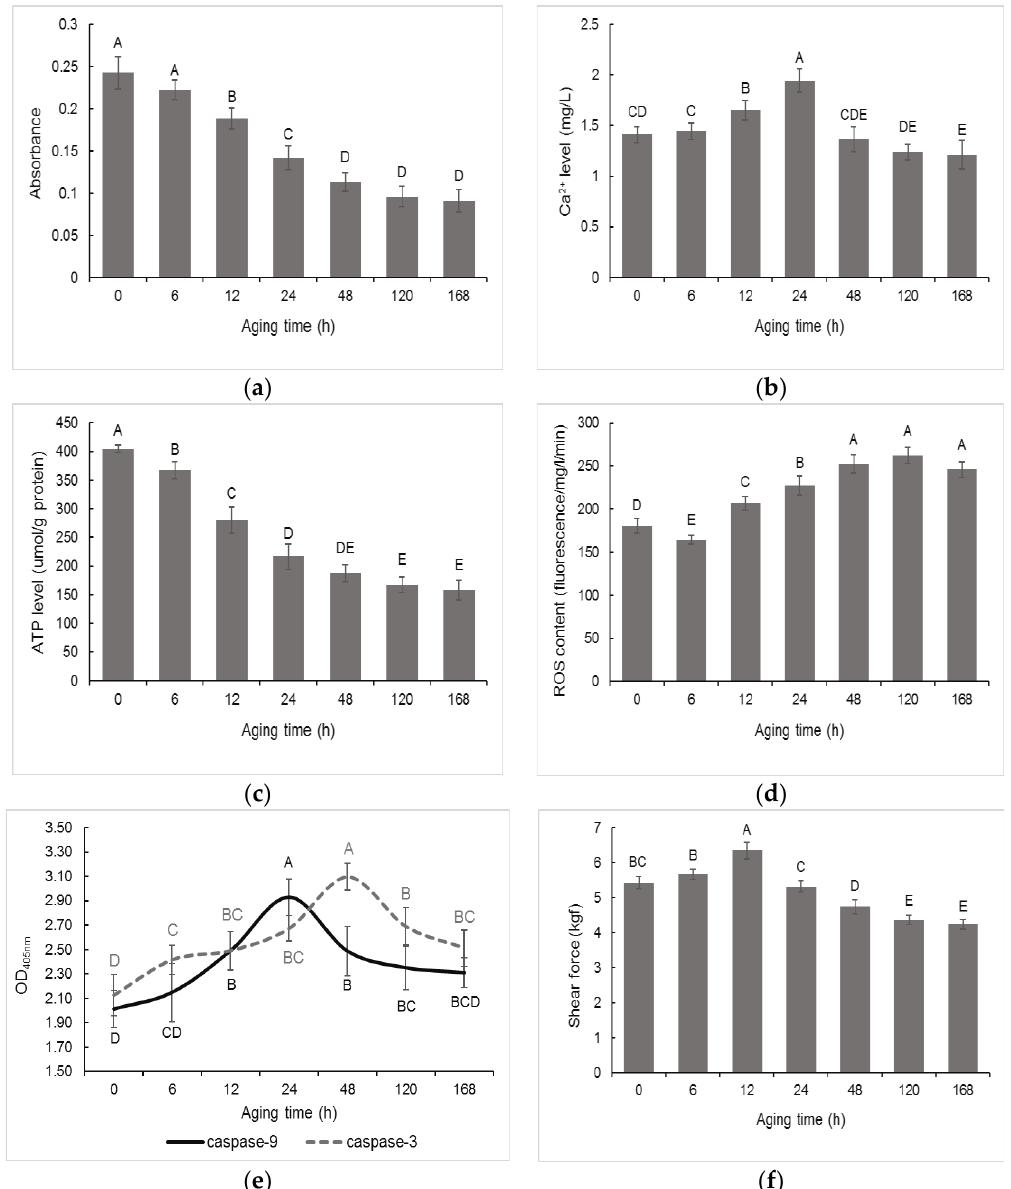
Figure 1. Changes in apoptosis related factors and tenderness in postmortem pork muscle. ( a ) mito- chondrial membrane permeability (MMP), ( b ) Ca 2+ level, ( c ) ATP level, ( d ) reactive oxygen species (ROS) content, ( e ) caspase-9/-3 activity, ( f ) shear force. Different capital letters represent the difference between aging ( p <